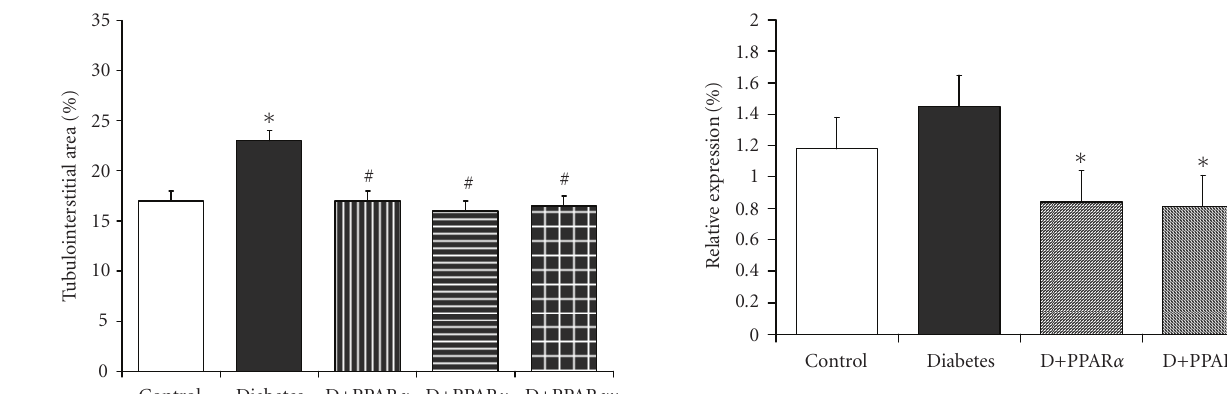
Figure 2: An increase in renal tubulointerstitial area associated with streptozotocin diabetes in apoE KO mice is attenuated following treatment with PPAR γ agonist, rosiglitazone, PPAR α agonist, gem- fibrozil, or the dual PPAR α / γ agonist, ragaglitazar.